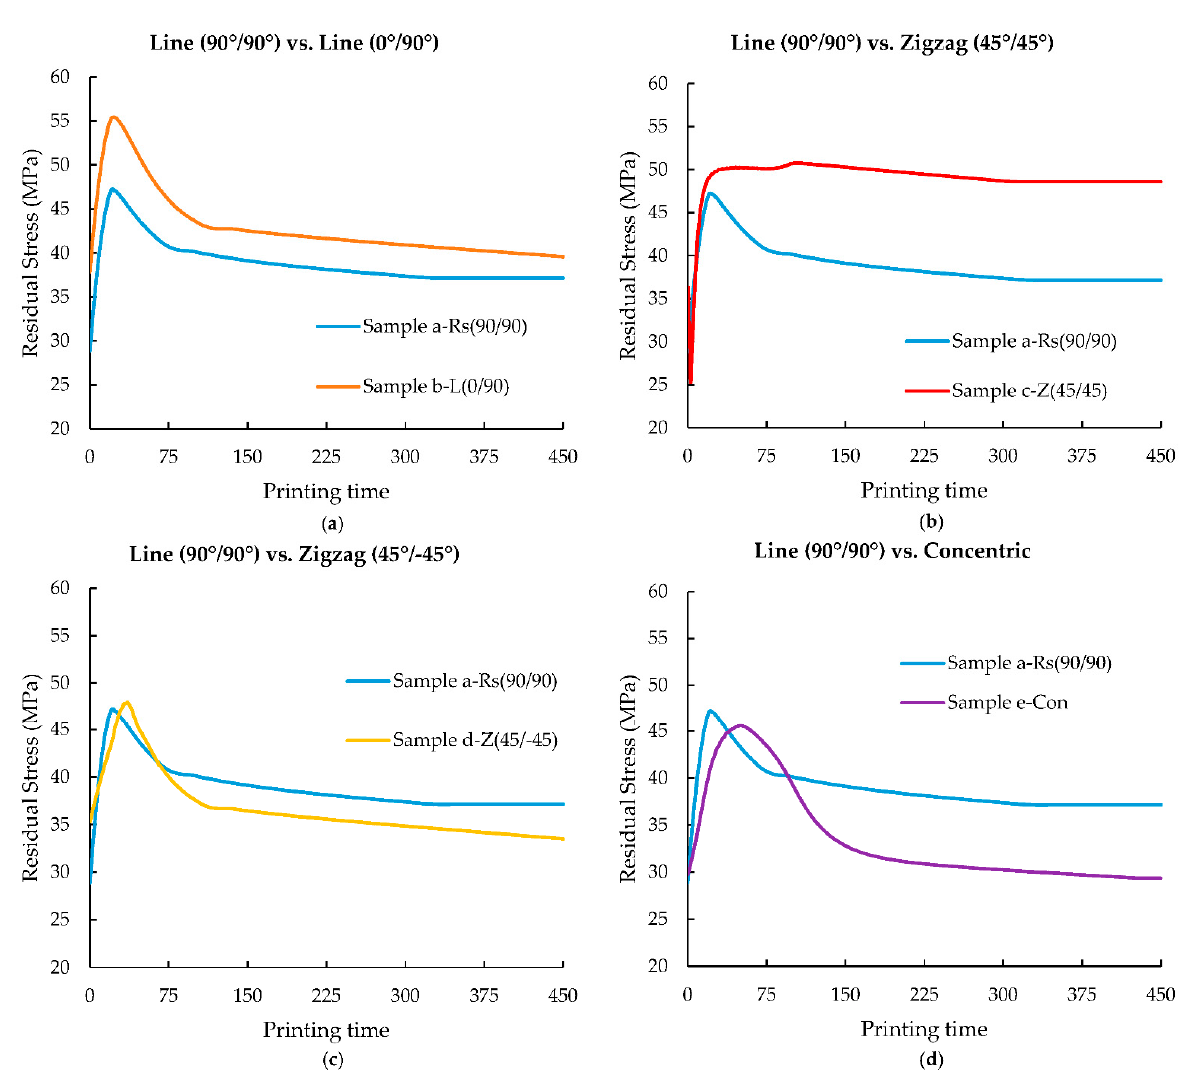
Figure 7. Comparison of residual stress results from ( a ) sample b-L (0°/90°), ( b ) c-Z (45°/45°), ( c ) d-Z (45°/ − 45°), ( d ) e-Con plotted against the printing time (dimensionless) and compared with sample Rs (90°/90°) (reference sample).